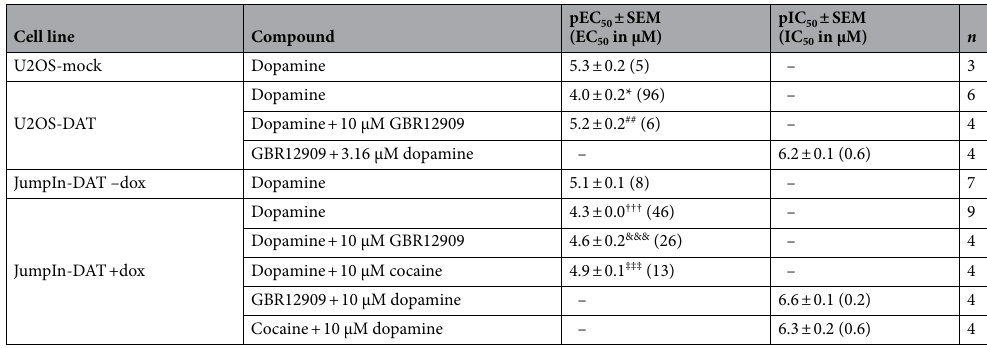
Table 1. Apparent potency values of dopamine (pEC 50 ) and inhibitory potency values of DAT inhibitors (pIC 50 ) on U2OS-mock, U2OS-DAT or JumpIn-DAT (± dox) cells in TRACT experiments using a non-linear regression analysis model with a fixed pseudo-Hill slope of 1. Values are reported as the mean ± SEM of three